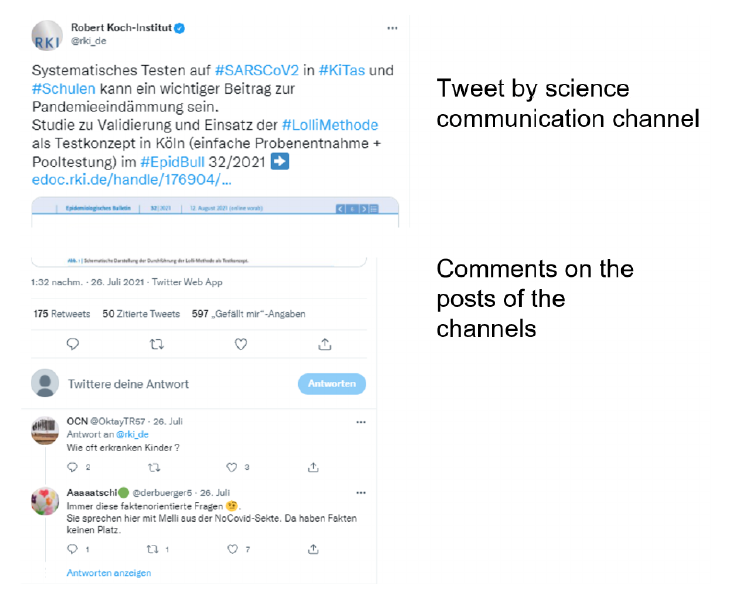
Figure 1. Schematic example of social media material used for